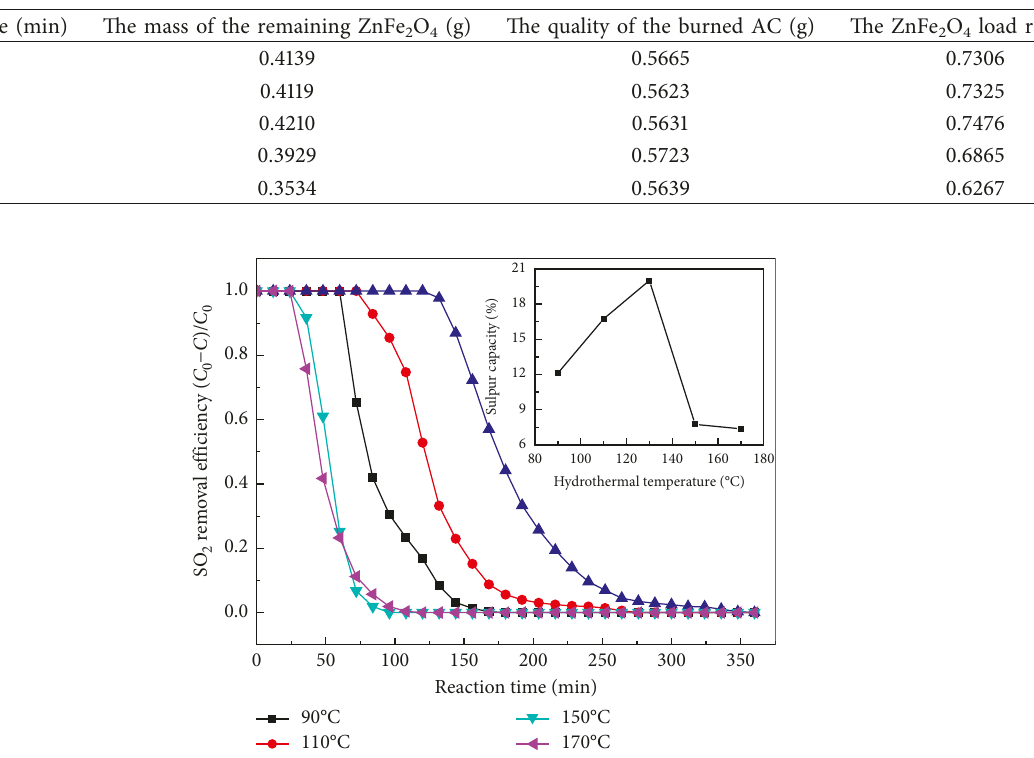
2 O 4 load ratio.